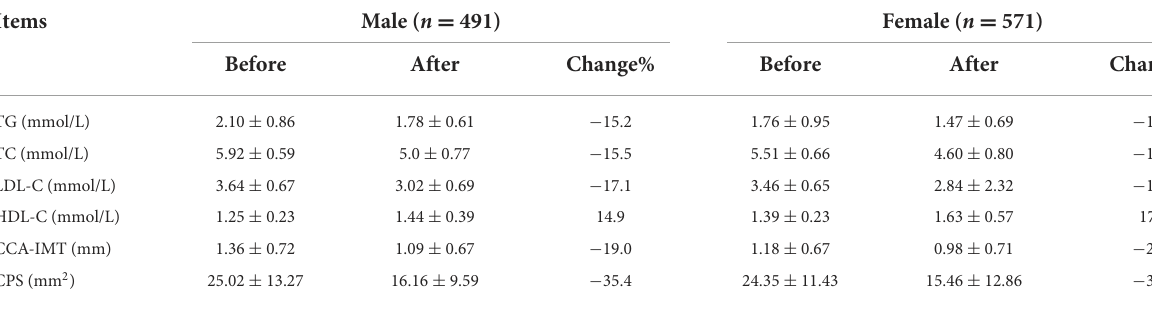
TABLE 6 Comparison of the effects of NK at two different doses on the lipid profile and atherosclerosis progression. Item 3,600 FU ( n = 61) 10800 FU ( n = 1,001) Before After Change% Before After